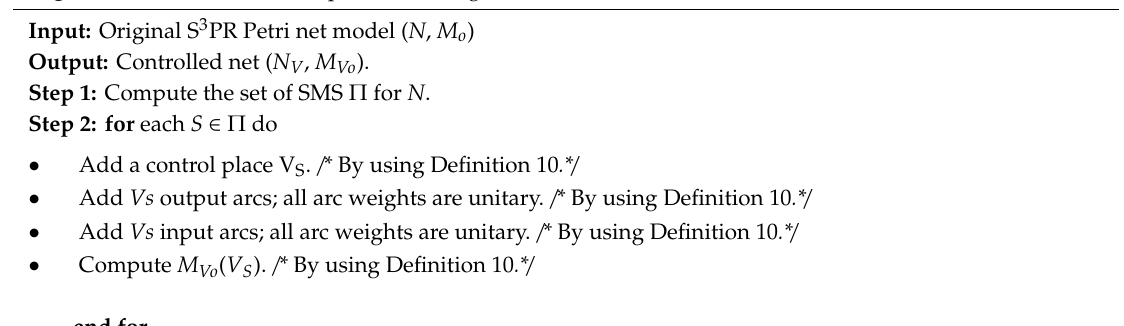
Algorithm 1: Strict minimal siphon-based algorithm